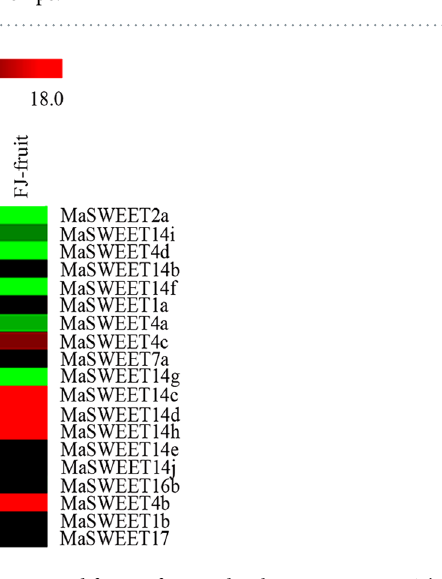
Figure 3. Phylogenetic and motif analyses of MaSWEET proteins. All proteins were identified by MEME database with the complete amino acid sequences of each MaSWEET identified. MaSWEETs were classified into Clades I-IV based on their phylogenetic relationships.